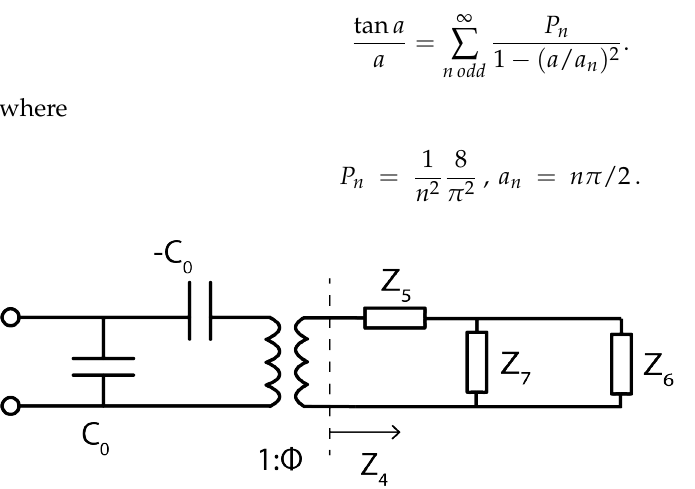
Figure 7. Modified Mason equivalent